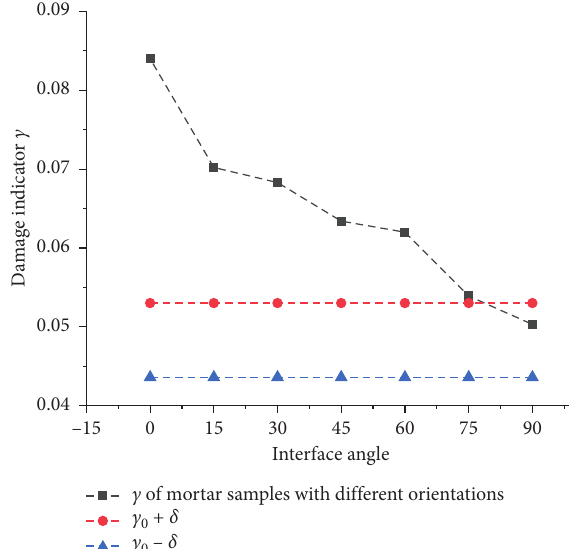
Figure 19: Damage indicator c in specimens A1 ∼